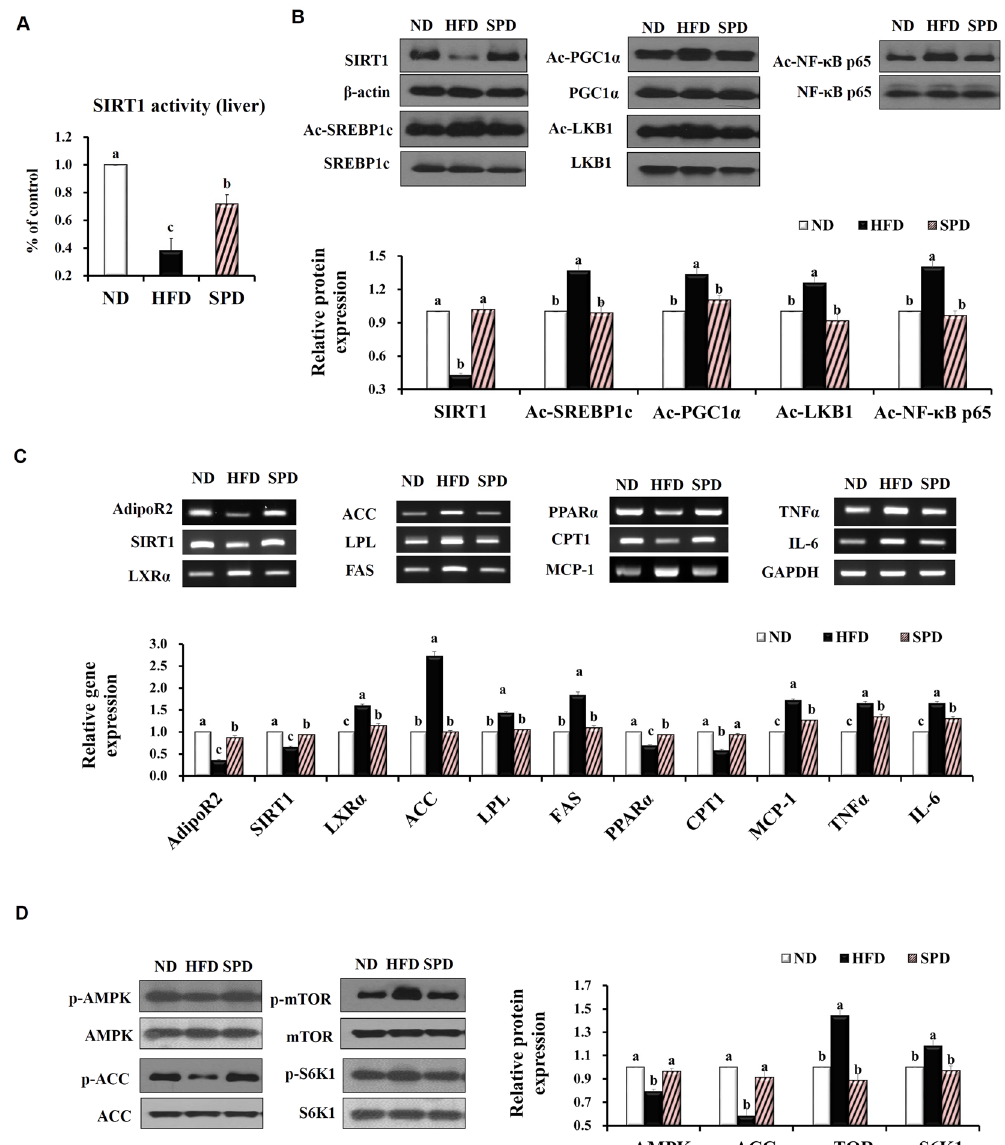
Figure 5. Scopolin activates SIRT1-mediated signaling cascades in mouse livers. ( A ) Catalytic activity of SIRT1 in the liver of mice fed experimental diets. ( B ) Representative Western blots bands and quantitative comparison of SIRT1 protein levels (normalized by corresponding β -actin expression level) and acetylated SREBP1c, PGC-1 α , LKB1, and NF- κ B levels (normalized by corresponding total SREBP1c, PGC-1 α , LKB1, and NF- κ B expression levels). ( C ) Representative RT-PCR product bands and quantitative comparison of mRNA expression of AdipoR2, SIRT1, LXR α , ACC, LPL, FAS, PPAR α , CTP1, MCP-1, TNF α , and IL-6 in livers from different groups. GAPDH was used as a normalization control. ( D ) Representative Western blots bands and quantitative comparison of p-AMPK, p-ACC, p-mTOR, and p-S6K1 levels in livers from different groups, normalized by corresponding total AMPK, mTOR, S6K1, and ACC expression levels. The full-length blots/ gels are presented in Supplementary Figs 2–4. Results are means from an n = 8 ± SEM of three independent experiments ( n = 2 or 3 per experiment) for each group. Different letters indicate statistical significance, p <